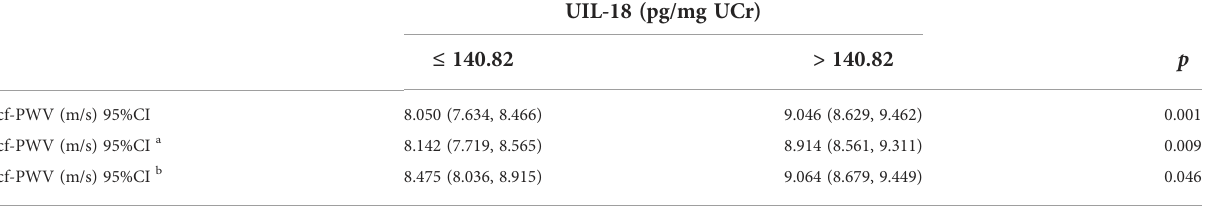
TABLE 4 Median of cf-PWV for subjects with T2D grouped according to the urinary levels of